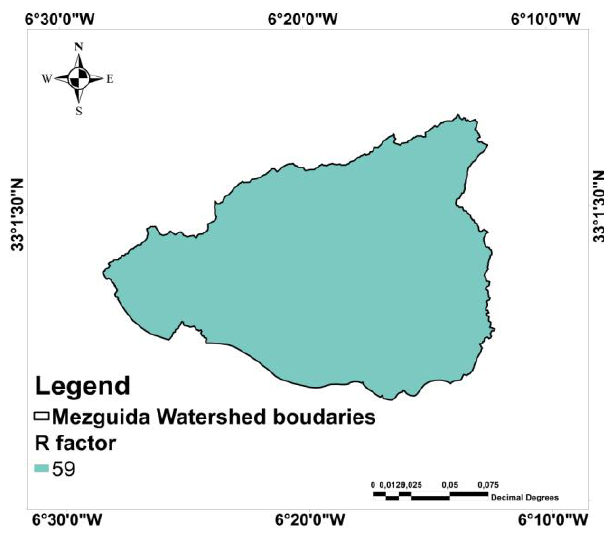
Figure 8. R factor